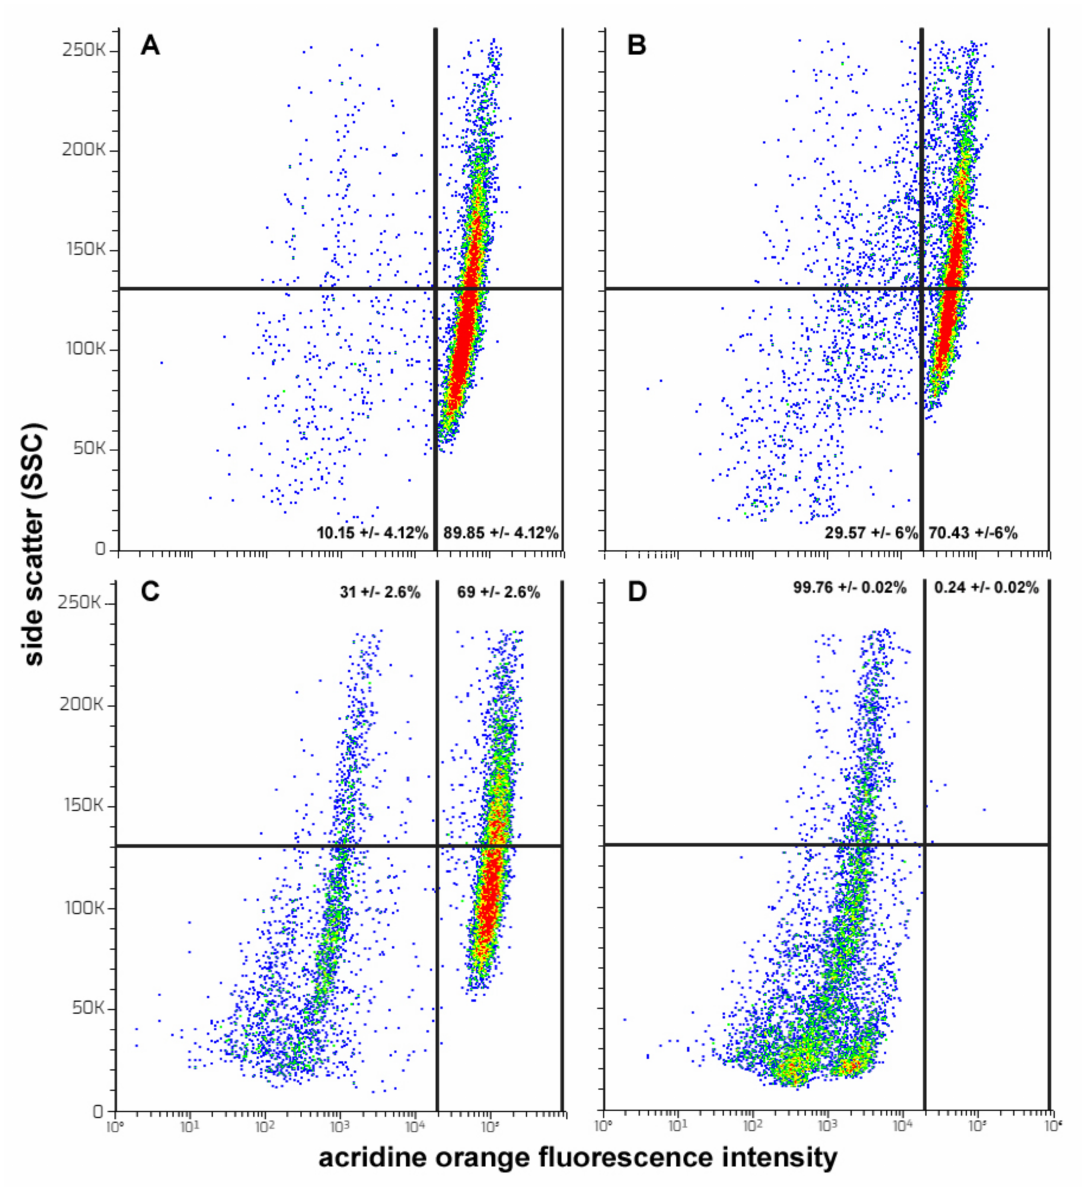
Figure 8. Flow cytometric assays for AVO accumulation in HepG2 cells grown under control condi- tions for 4 h ( A ) and 24 h ( C ) or incubated with IC 50 24 CFE for 4 h ( B ) and 24 h ( D ). The plots show the results of representative experiments, and the percentages indicated as the mean ± s.e.m. of three independent experiments refer to AVO + cells (right quadrants) and AVO − cells (left quadrants). In light of the observed cytotoxic role played by the CFE from A. lixula on HepG2 tumor cells, proteomic analysis of the preparations was performed after proteolysis of the samples and MS sequencing to detect bioactive components. Overall, 1952 obtained spectra matched forward peptides, and the final output reported 104 forward and 20 reverse proteins and 329 unique forward peptides. The estimated spectrum-level FDR on true proteins was 0.3%. A bioinformatic similarity search against the BlastP database identified 28 proteins contained in the CFE and potentially associated with the various aspects related to the derangement of HepG2 cell biological activities reported previously here, as well as with exosome secretion. The peptide sequences and the results of alignments selected on the basis of sorting by the best E value are reported in Table